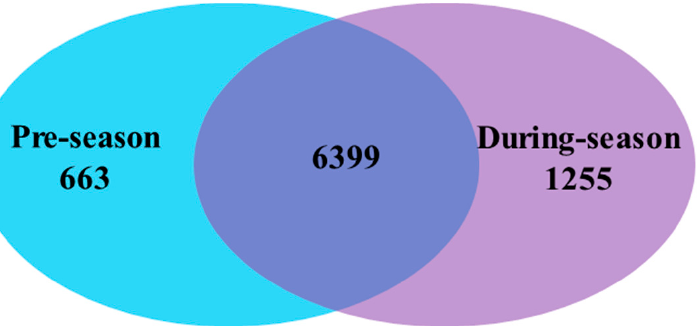
Figure 4. Two-way Venn diagram for bacterial commonness of soil bacterial species between pre- season and during-season soil samples.